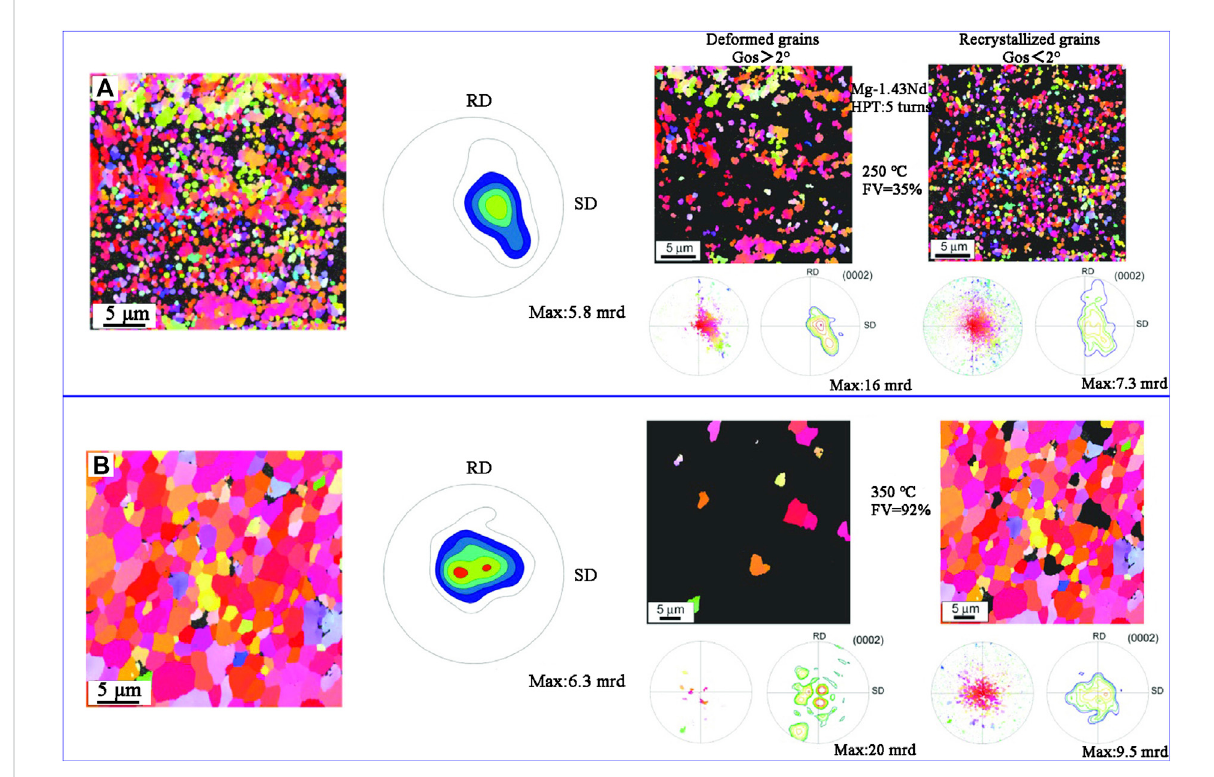
FIGURE 7 Texture of Mg-1.43Nd alloys processed by HPT after annealing at 250 ° C (A) and 350 ° C (B) (Tighiouaret et al.,